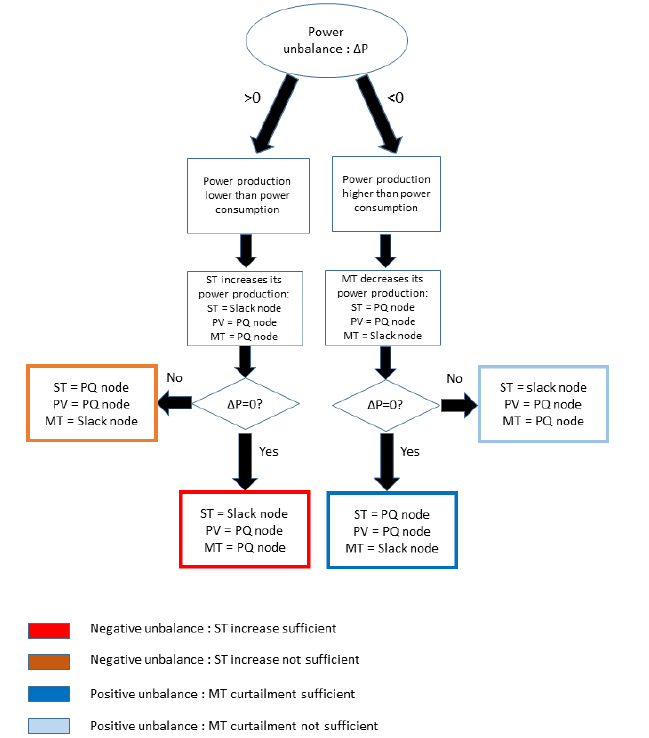
Figure 4. Flowchart of the operation